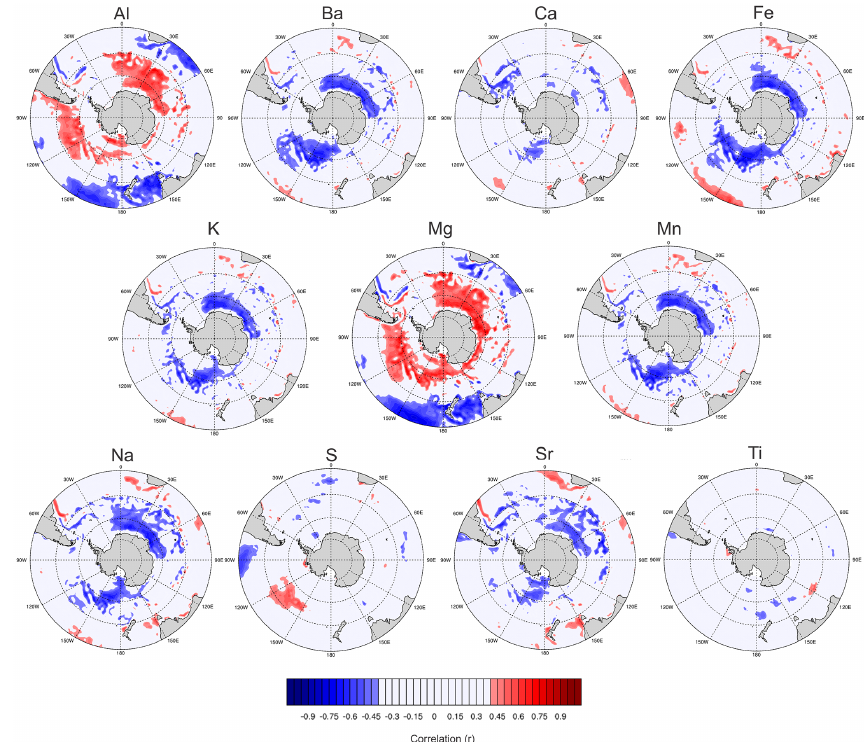
Figure 6. Correlation of the 1979–2008 ERA-Interim reanalysis sea surface temperature (SST) parameter with the annually averaged trace elements time series in the MJ ice